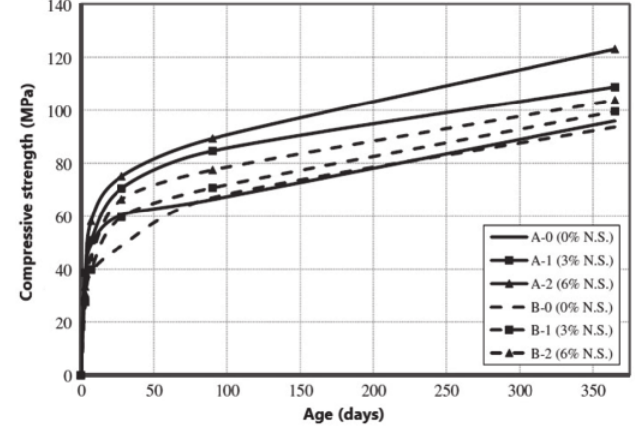
Compressive strength evolution of the mixtures Source: Adapted from SAID et al. [3]